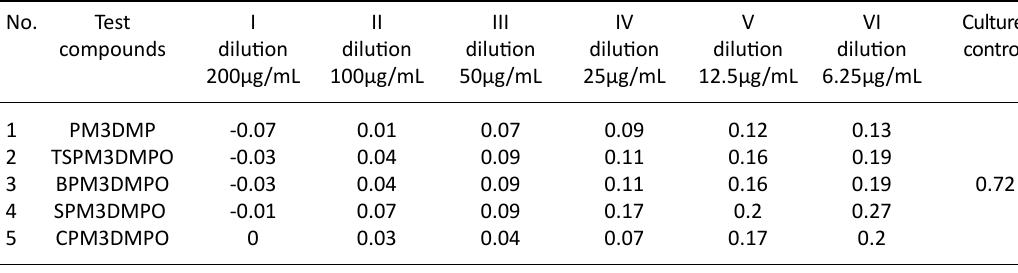
Table 6. MIC of Piperidines against Staphylococcus sp. at 600 nm